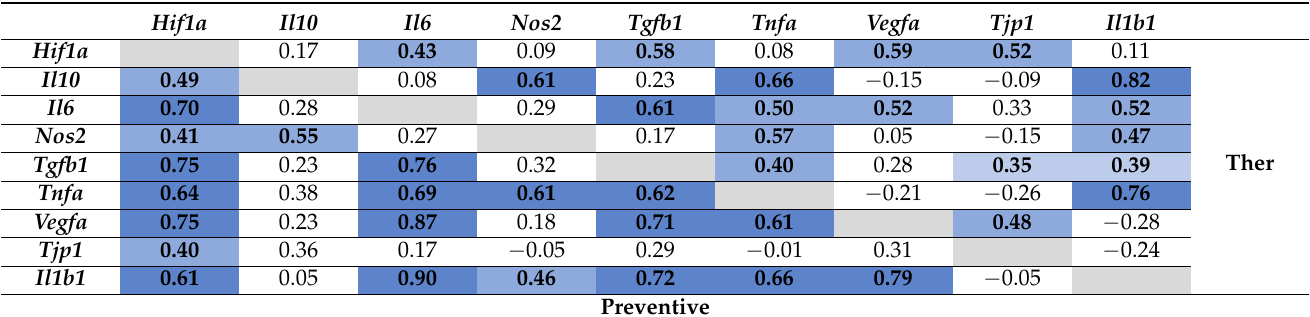
Table 2. Correlation between inflammatory and oxidative stress mRNA expression in the TNBS model in both therapeutic and preventive approaches.